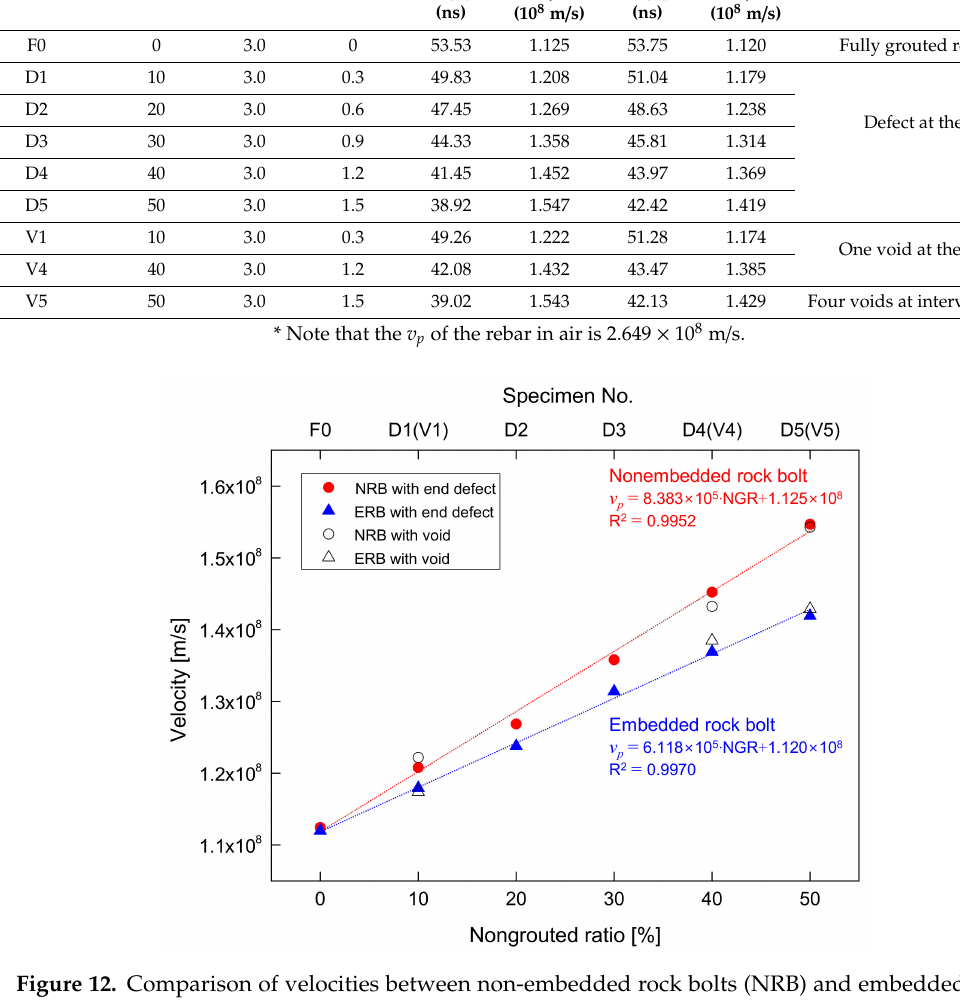
Table 1. Round-trip travel times reflected at rock bolt ends ( ∆ t end ) and propagation velocities ( v p ). Specimen No